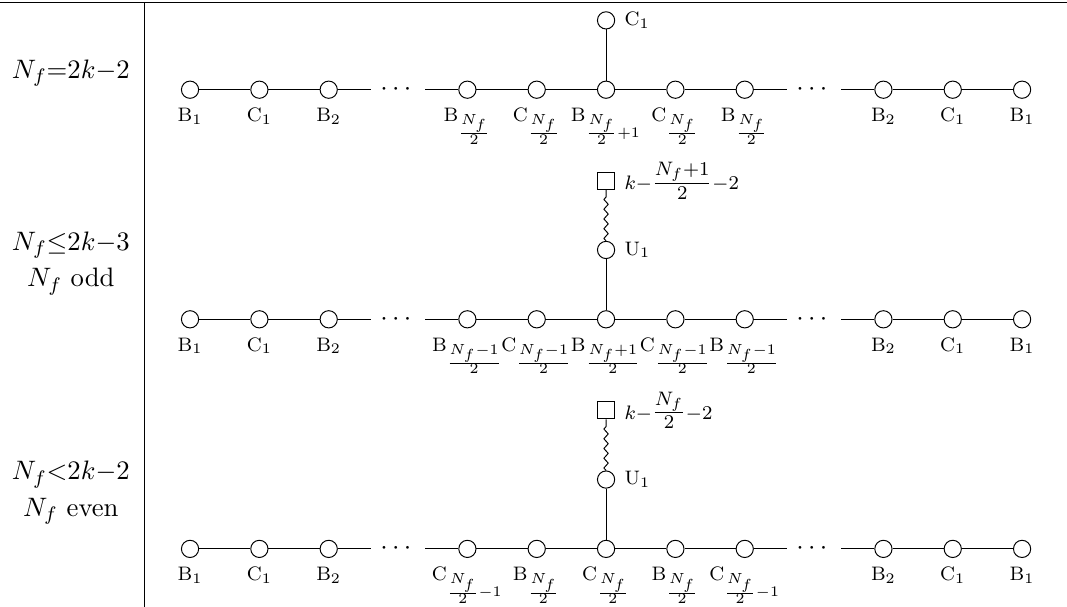
Table 12 . In(cid:12)nite coupling Higgs branches for O(2 k + 1) theories with N f (cid:13)avours. The moduli space dimensions match the increase due to the new Higgs branch directions at in(cid:12)nite coupling [10] compared to (cid:12)nite coupling of table